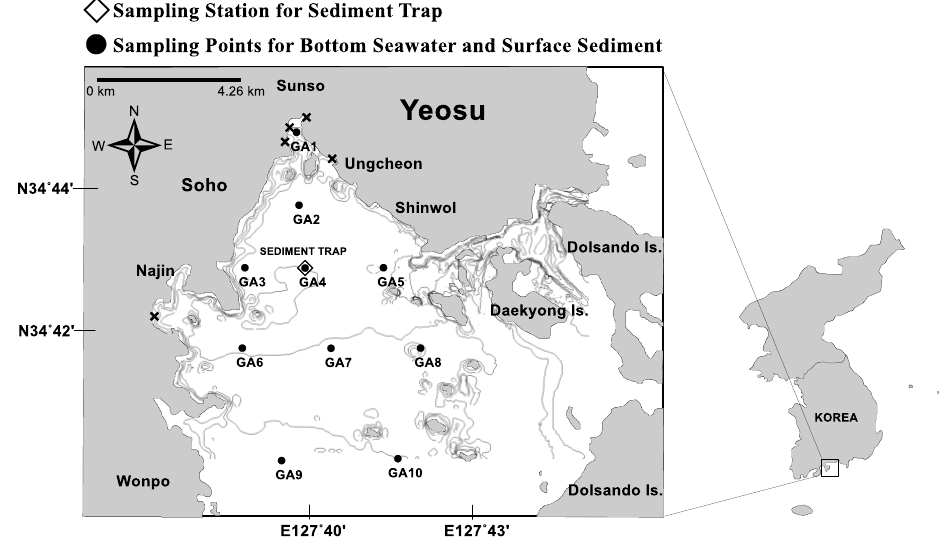
Figure 1. Scheme of sampling points for bottom seawater, surface sediments, and sediment traps in Gamak Bay, Korea, August 2017. The contour means the water depth, indicating 2 m, 4 m, 6 m, 8 m, 10 m, and 15 m (https://www.khoa.go.kr/eng/Main.do, accessed on 24 April 2022).